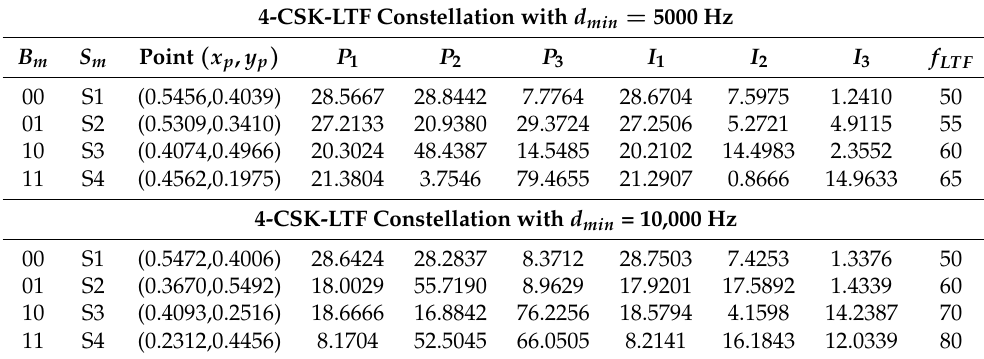
Table 1. 4-CSK-LTF